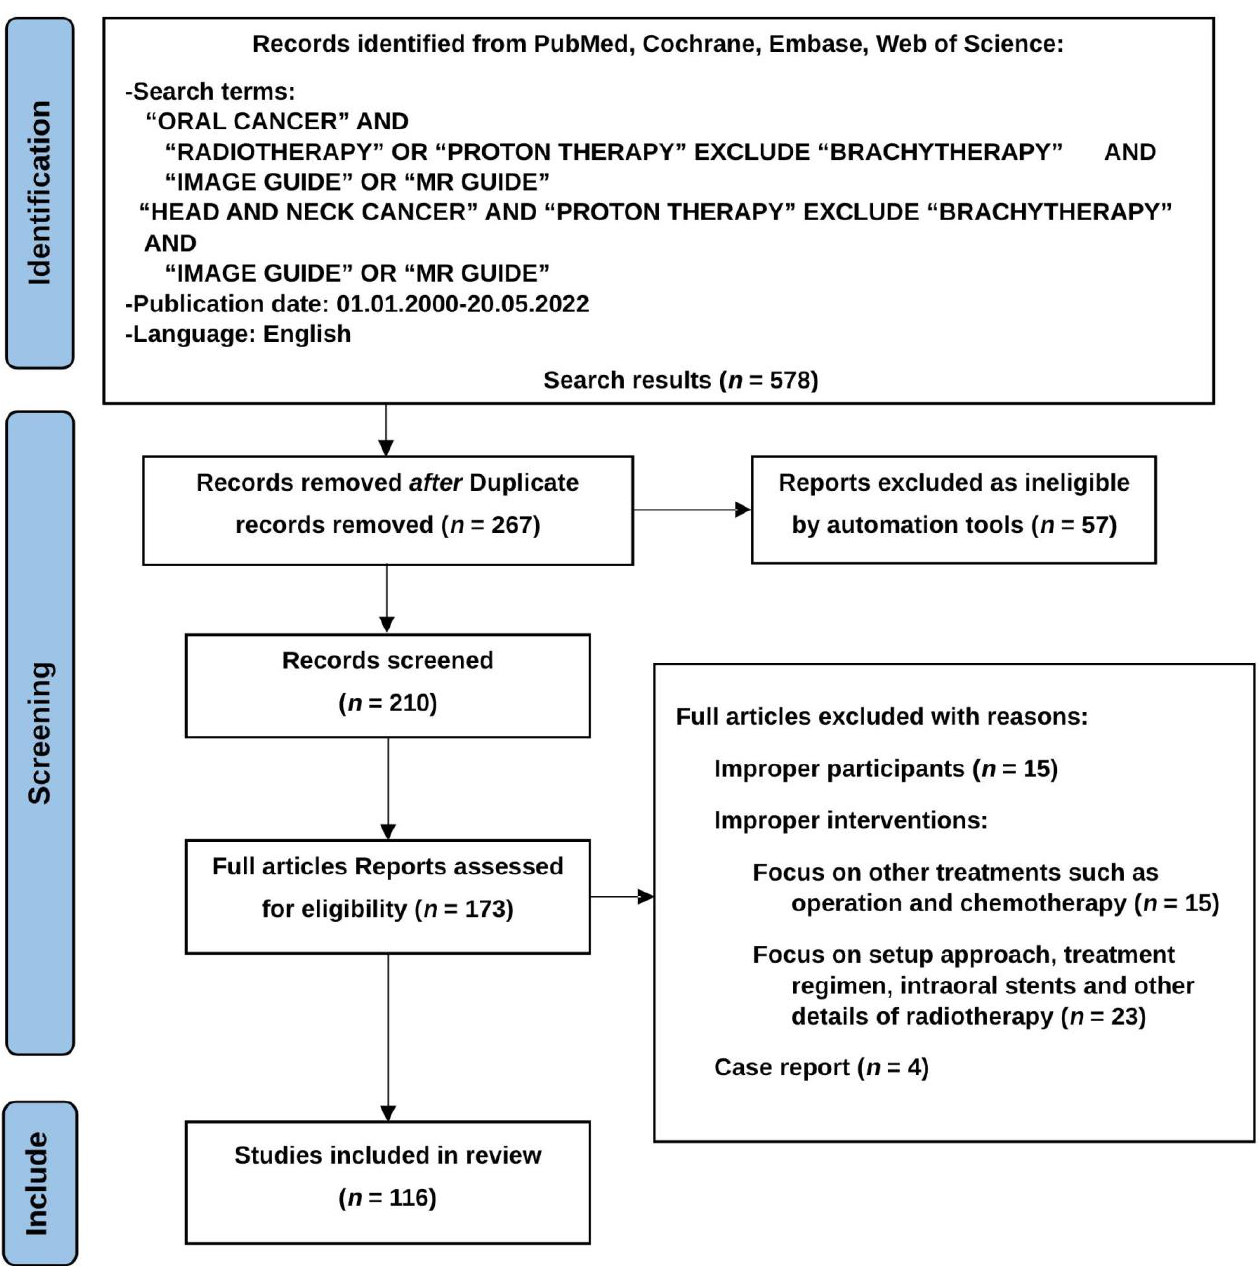
Figure 1. To conduct the systemic literature review, published trials were reviewed and collected from electronic databases. The PICOTS structure was used for clinical question evaluation and search guidance.